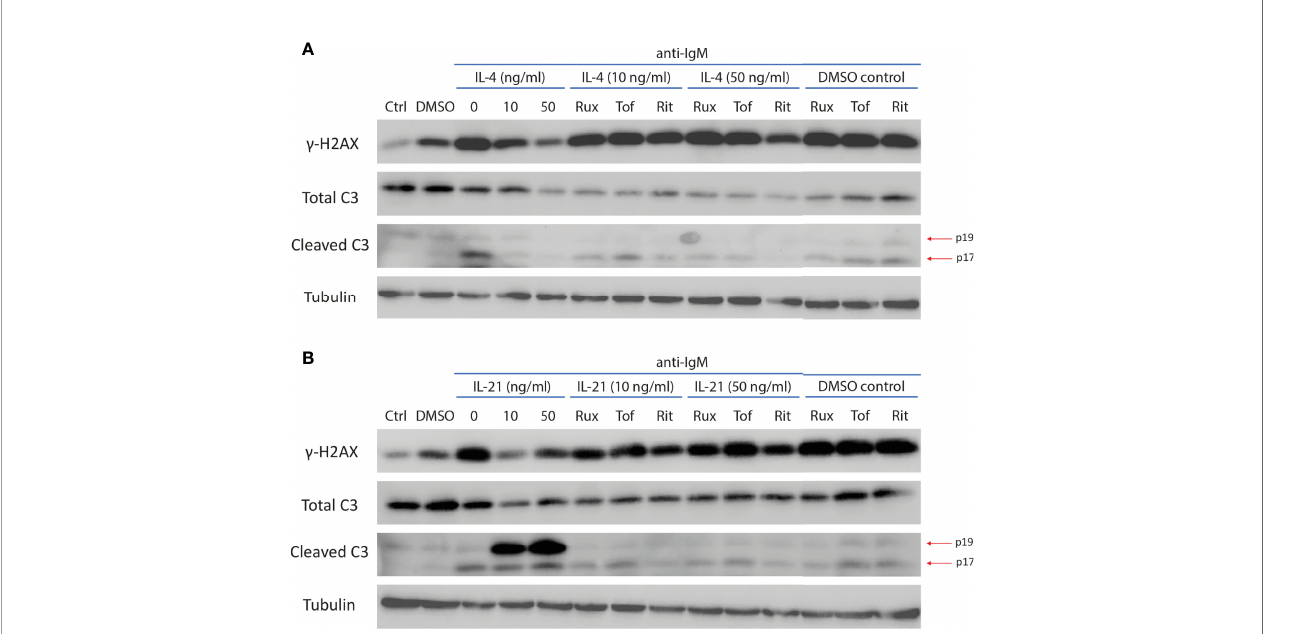
FIGURE 8 | JAK inhibitors reversed IL-4 and IL-21 induced modulation of caspase 3 activity and DNA damage marker. (A) Representative images of western blot showing all JAK inhibitors reversed IL-4 effects in downregulating expressions of mature cleaved caspase 3 (p17) and g -H2AX during anti-IgM stimulation. (B) Representative images of western blot showing all JAK inhibitors reversed IL-21 effects in suppressing expression of g -H2AX and intermediate cleaved caspase 3 (p19) accumulation during anti-IgM stimulation. The dose of anti-IgM was 2 µg/ml and cells were treated for 24